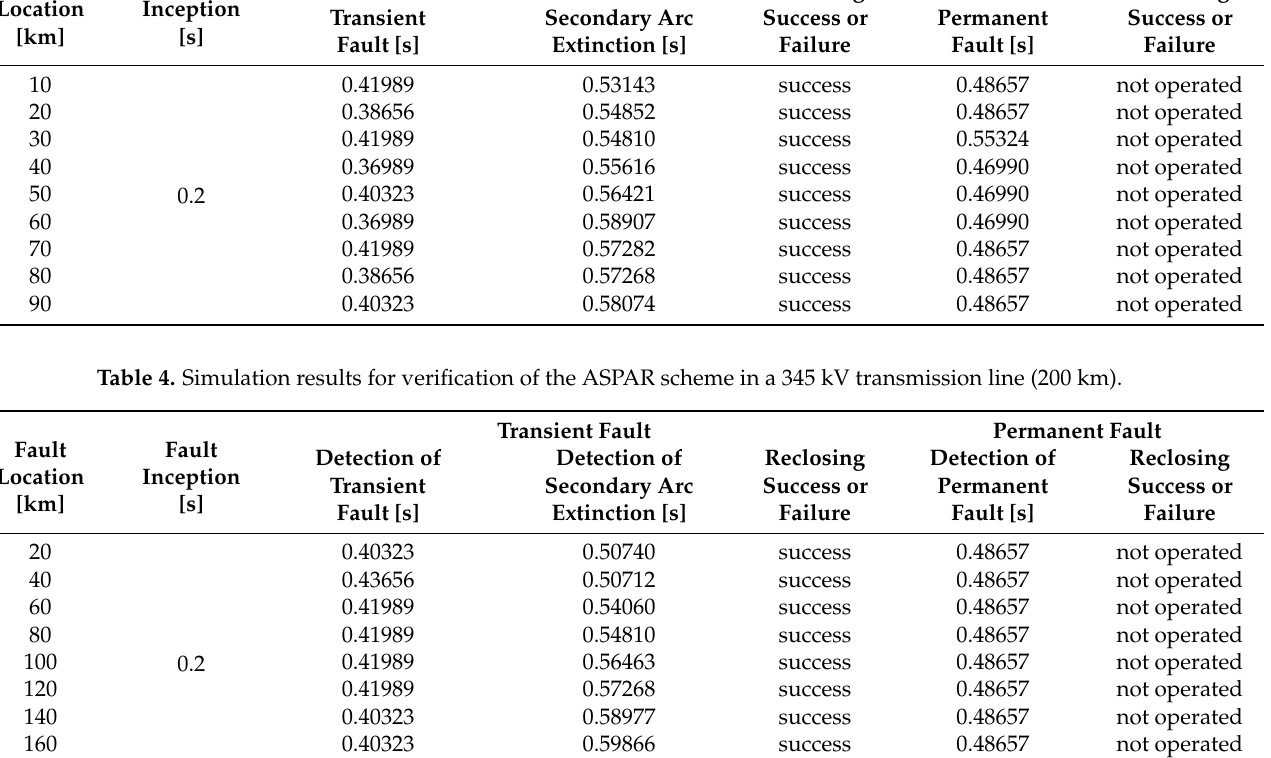
Table 3. Simulation results for verification of the ASPAR scheme in a 345 kV transmission line (100 km). Fault Location